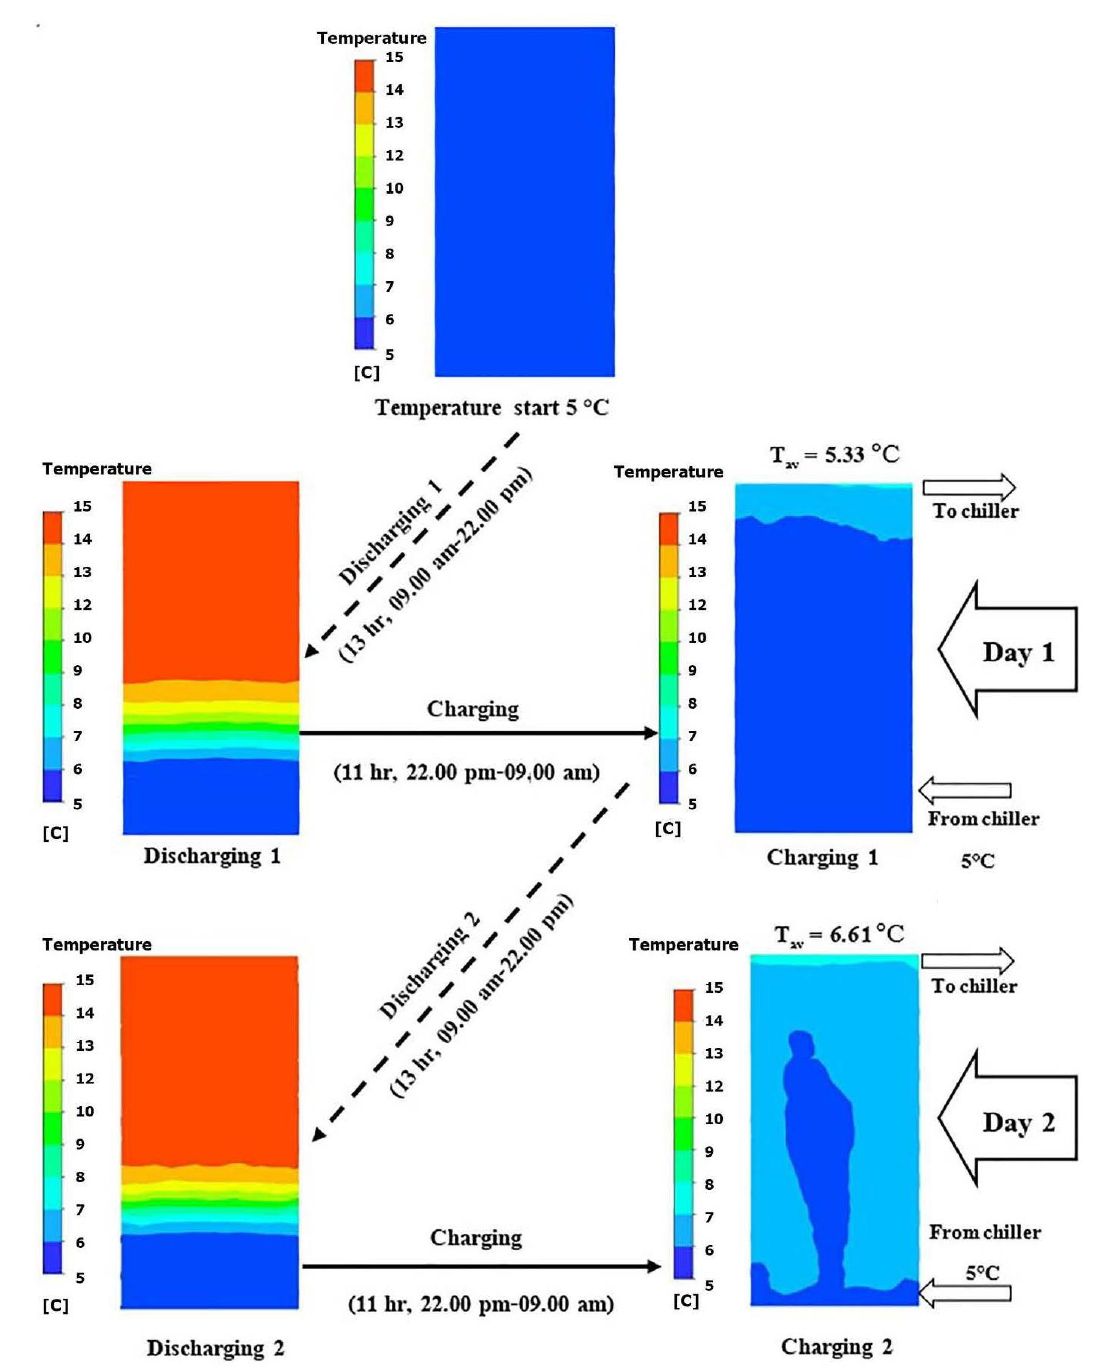
Figure 7. Temperature profiles during discharging and charging stages with 5 ° C chilled